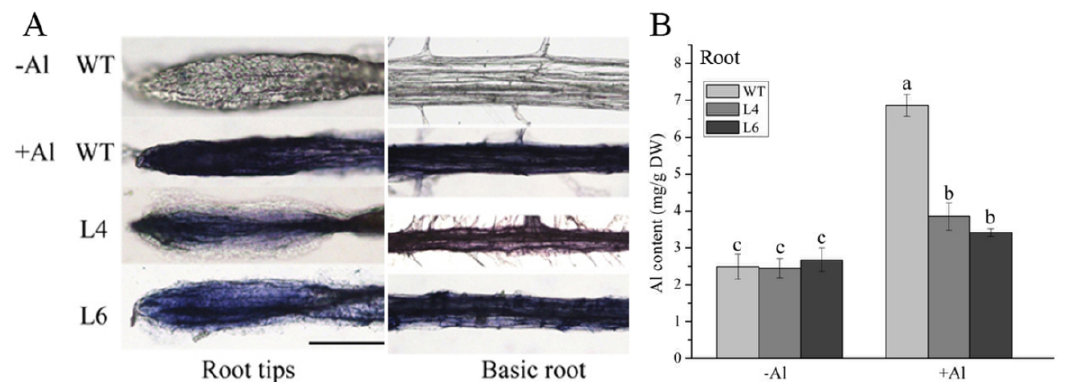
Figure 5. Al accumulation in roots is reduced in transgenic Arabidopsis . ( A ) Hematoxylin staining after 12 h exposure to 0 and 60 µ M AlCl 3 in roots. Scale bar: 50 µ m; ( B ) Al contents in lines (as in ( A )) under Al stress for 12 h. Values represent mean ± SD ( n ≥ 15). Different letters indicate significant differences ( p < 0.01) (Tukey’s